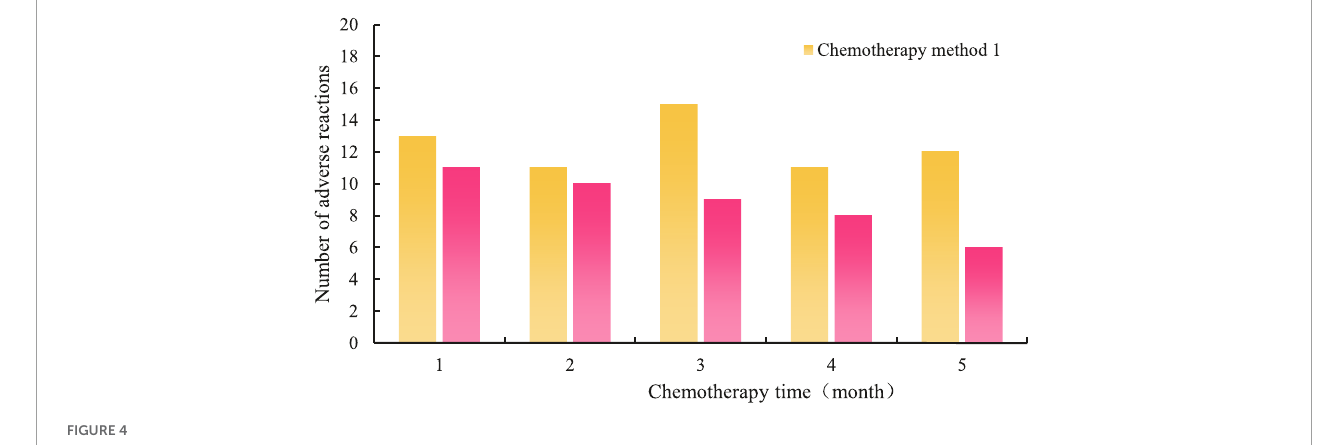
FIGURE4 Number of adverse reactions of patients under two chemotherapy methods.